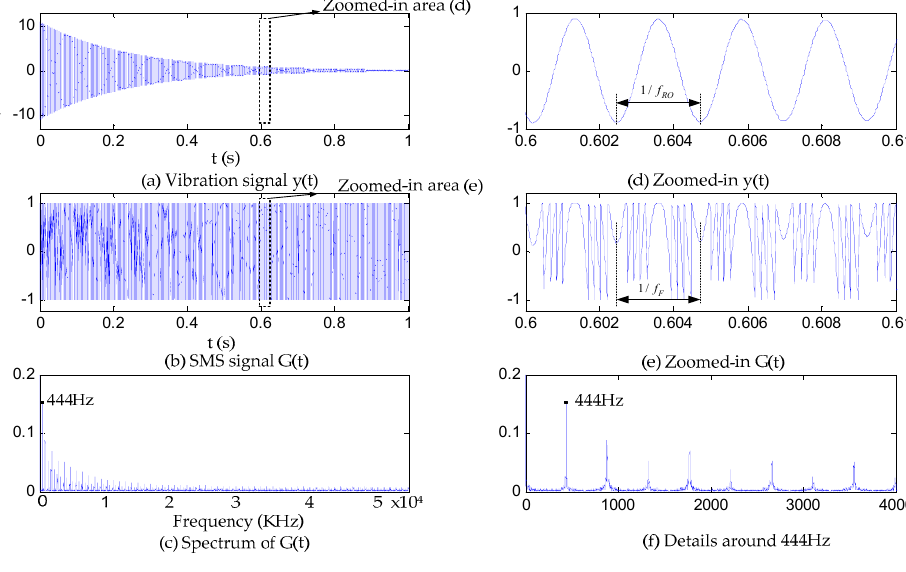
Figure 6. ( a – f ) Simulation results.